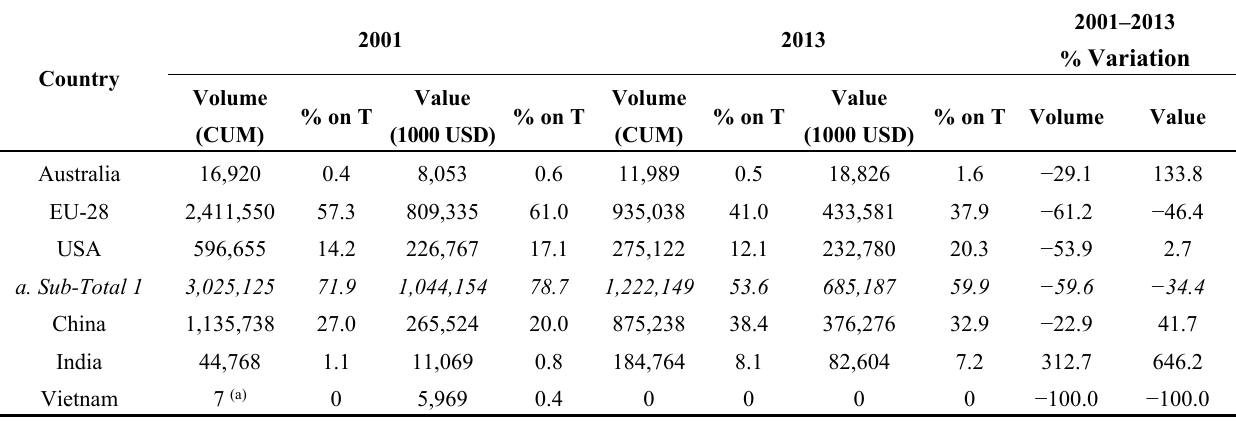
Table B2. Tropical timber product imports by selected countries from VPA countries, 2001 and